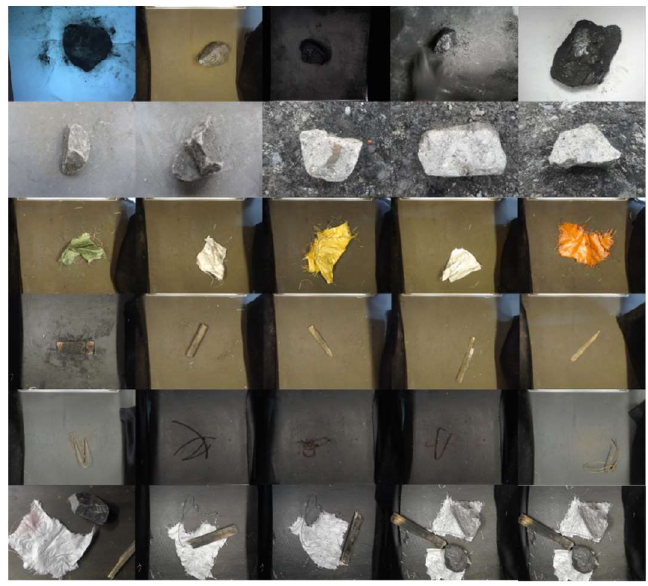
Figure 8. Images of coal foreign objects.